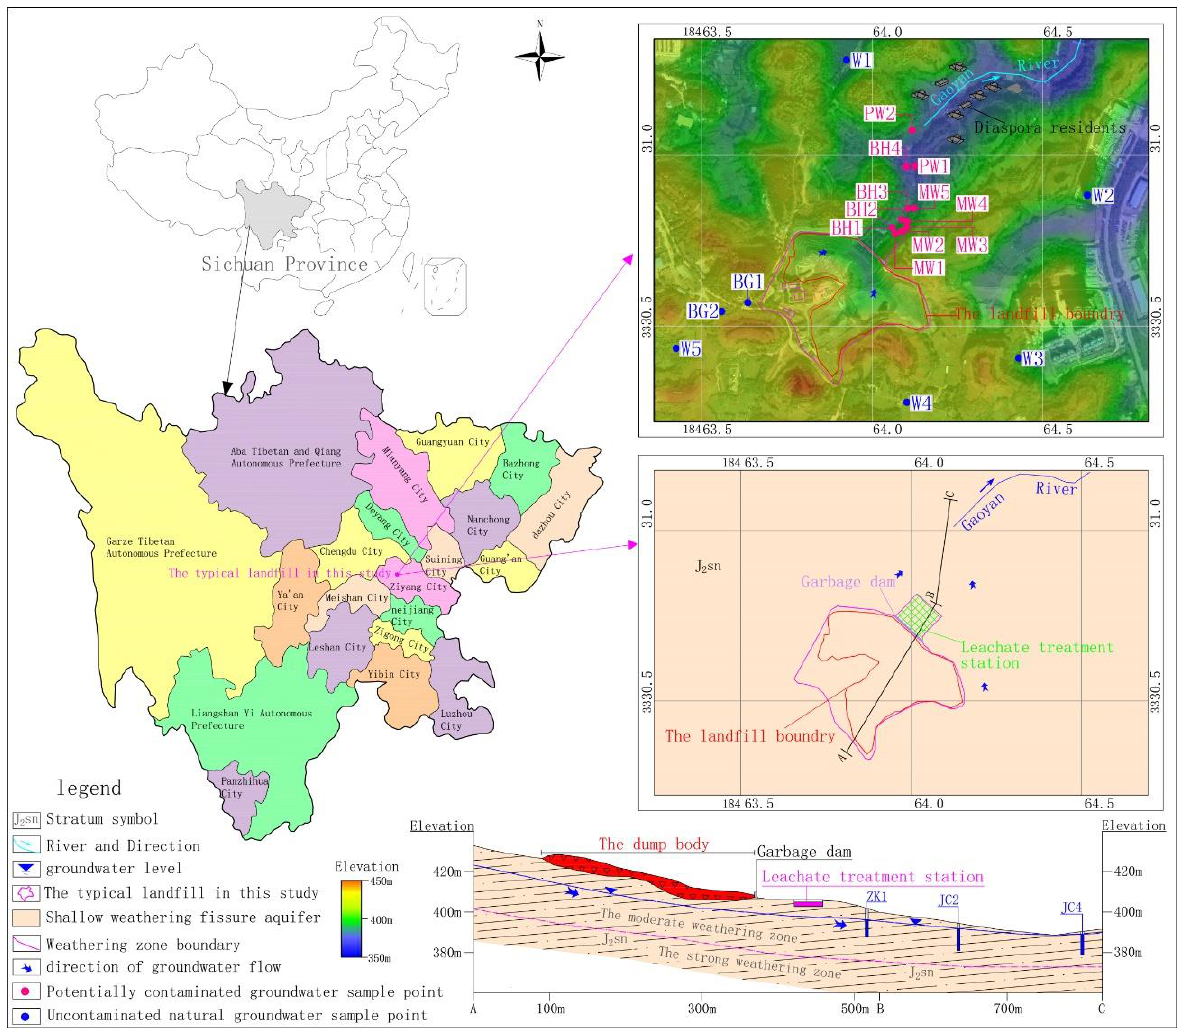
Figure 1. Location of the study area in Sichuan Province, China. The detailed inset in the upper right shows the topography of the study area, landfill layout and sampling points location. The detailed inset in the lower right shows the hydrogeological conditions of landfills.